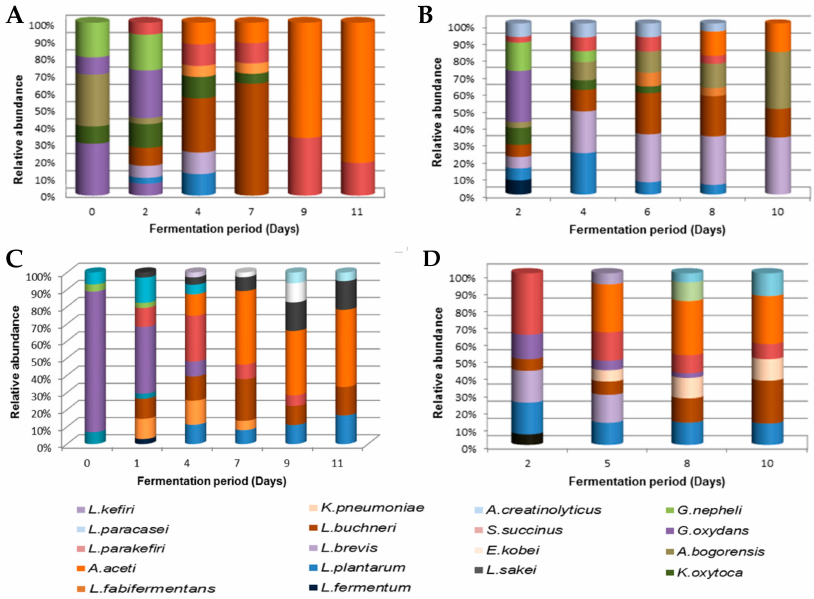
Figure 5. Bacterial species identified in marula wine from ( A ) Lab, ( B ) Mentz, ( C ) Moshira-A and ( D )